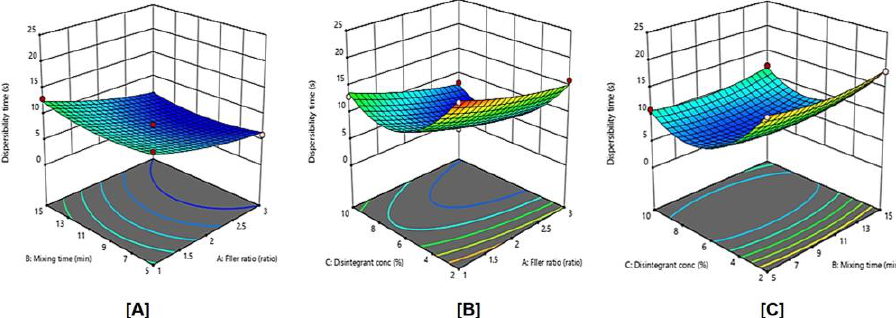
Figure 5. Influence of independent variables on the dispersibility time (Y1) with significance ( A ) p value = 0.4150, ( B ) p value = 0.0002, and ( C ) p value < 0.0001